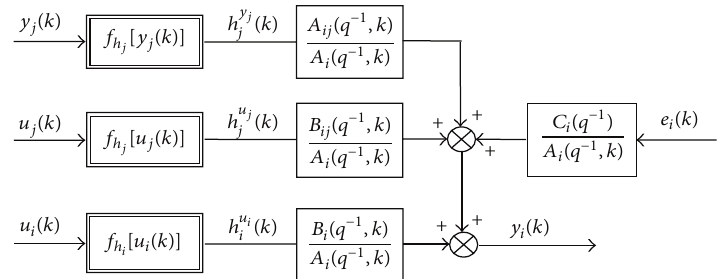
Figure 1: Structure of Hammerstein stochastic mathematical